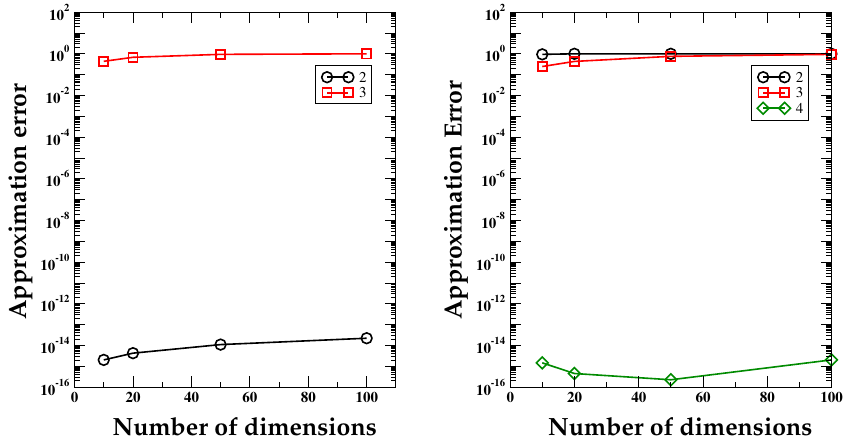
Figure 6. Test Case 5. Approximation error curves versus the number of dimensions d for the numerical integration of a singular function using different partitions of the multidimensional domains. We apply the Gauss–Legendre formula with m = 4. The plot on the left shows the errors computed using grids with two and three partitions per direction, and the singularity located at the middle of every direction. The plot on the right shows the same test case with grids with two, three, and four partitions per direction, and the singularity located at the three-quarter mark of every direction. When the singularity is located at an interface between two cells, the integration formula is exact and the error is of the order of the machine’s precision, independent of the number of